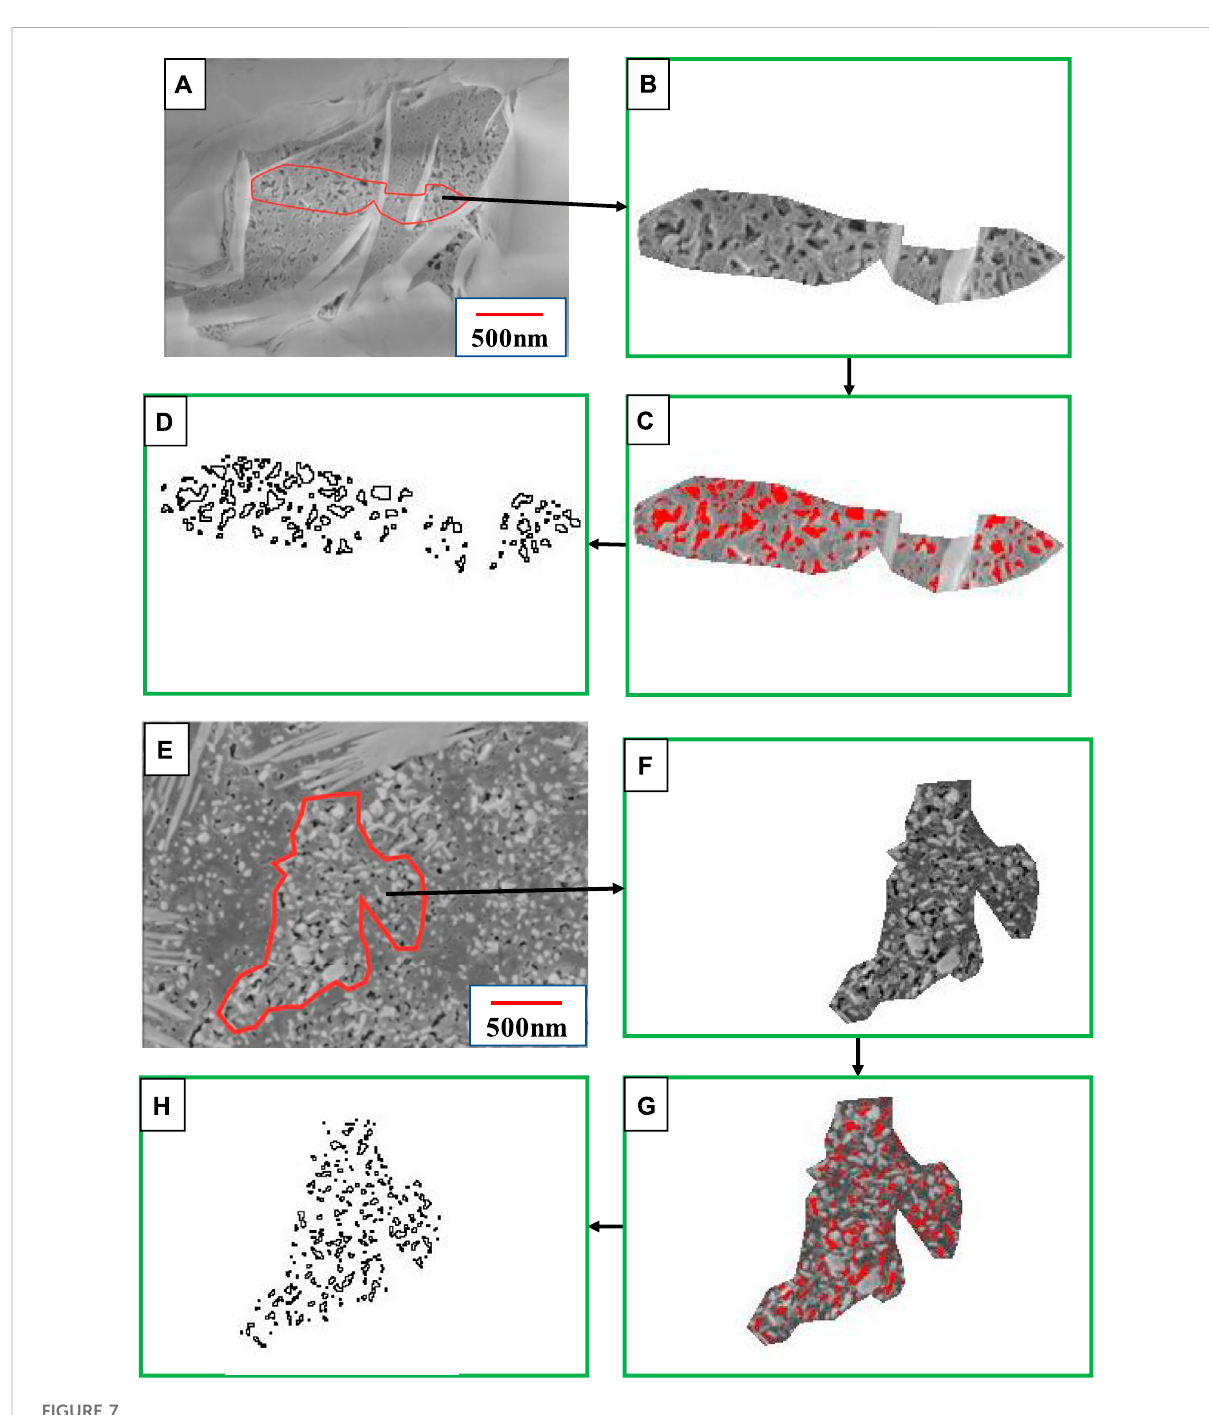
FIGURE 7 Pore types developed in the Lianggaoshan Formation shale in Well TYX and the image processing procedures of ImageJ. Solid bitumen pores and image processing procedures (A – D) , 2547.26 m; pores of solid bitumen-clay mineral complex mass and image processing procedures (E – H) , 2589.61 m;clay mineral pores and image processing procedures (I – L) , 2483.01 m; structured vitrinite pores and image processing procedures (M – P) , 2555.56 m; funginite pores and image processing procedures (Q – T) , 2547.26 m; detrital-vitrinite/detrital-inertinite pores and image processing procedures (U – X) , 2575.25 m. See Figure 1 for the well